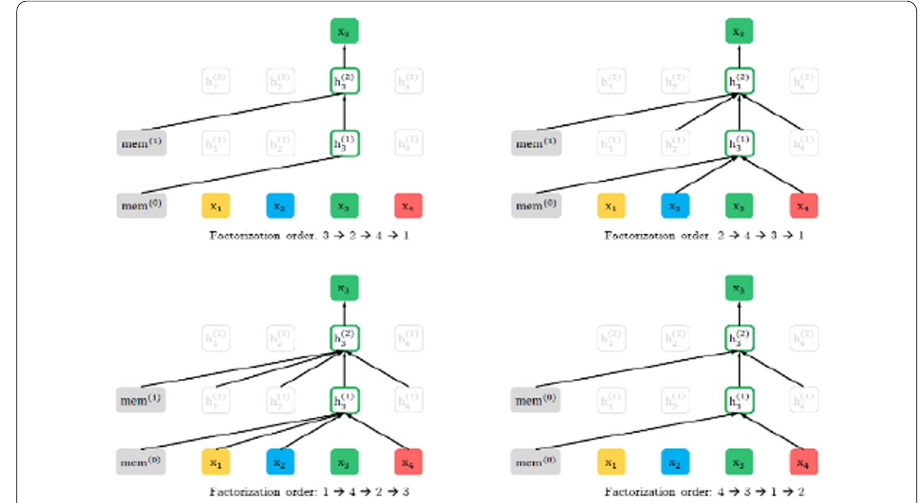
Fig. 3 Description of the Permutation Language Modeling for Predicting the token